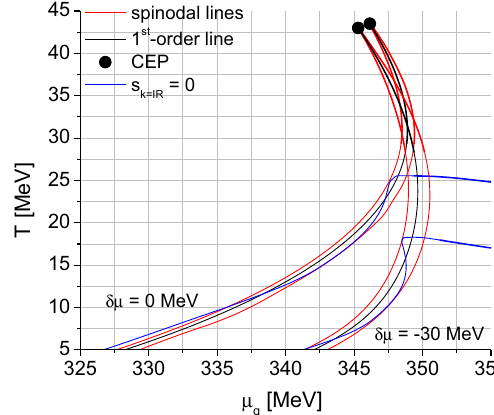
Fig. 4 First order phase transition of the QM model without vector interactions, for δμ = 0 and δμ = − 30MeV. The red, black and blue lines are the spinodals, first order phase transitions and the s k = IR = 0 lines, respectively. The CEPs are represented by the black dots. Entropy density is negative below the s k = IR = 0 line